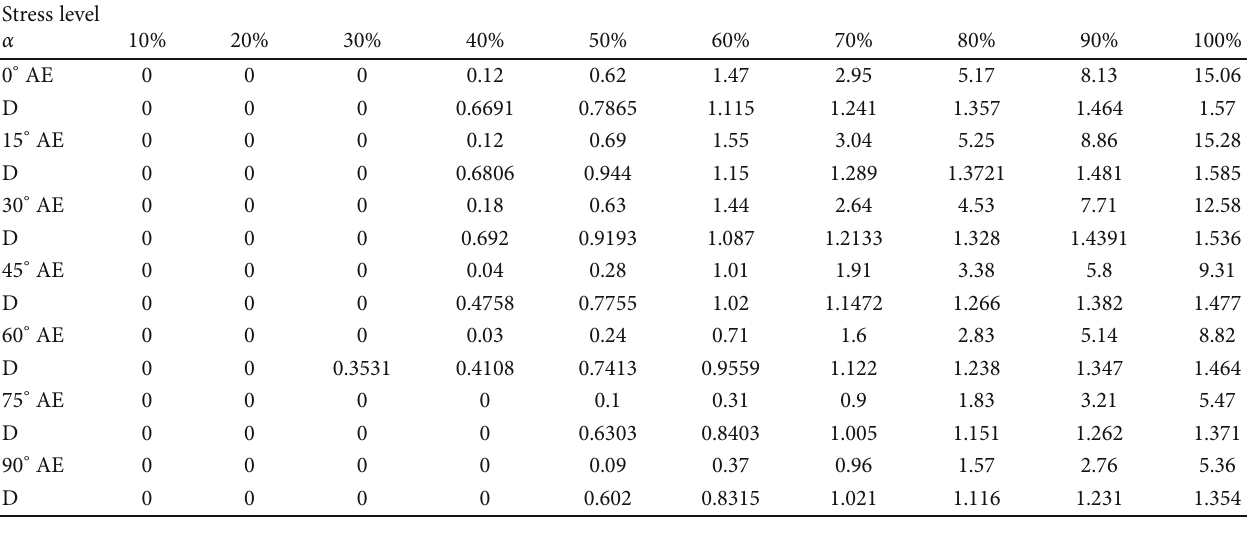
Table 4: AE energy and fractal dimension values.